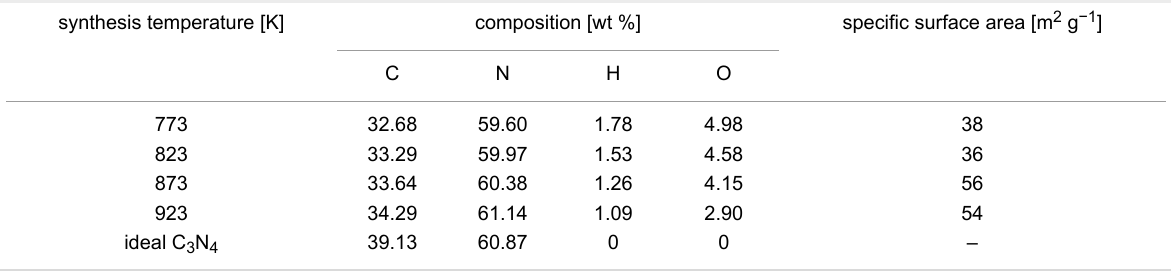
Table 1: Results of elemental analysis and specific surface area measurements.